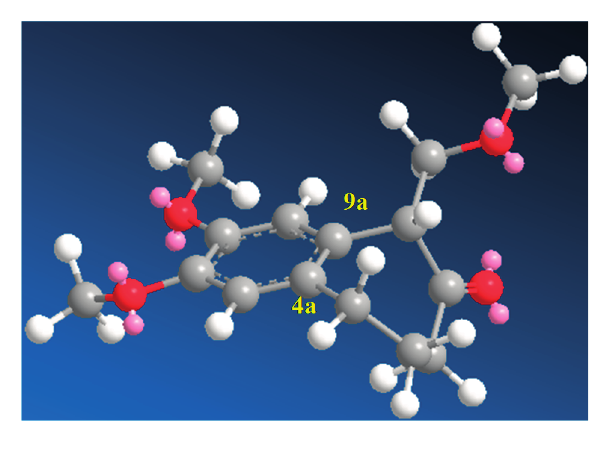
Scheme 5. Mechanism for the Formation of 12f .